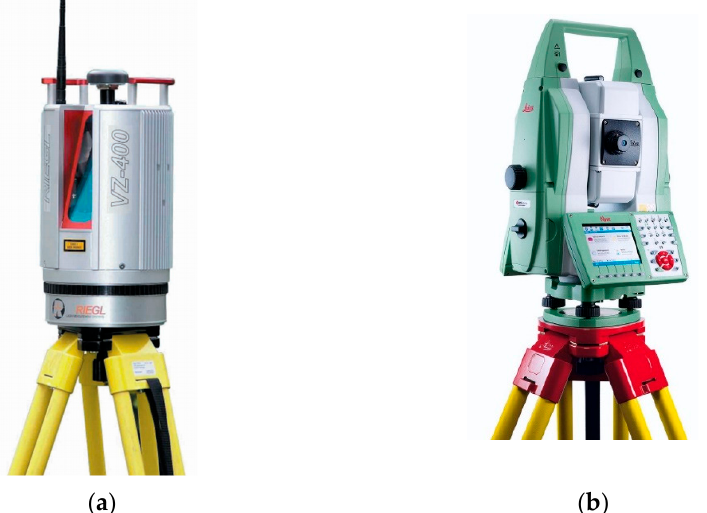
Figure 2. Scanning devices used in the experiments: ( a ) Riegl VZ-400; ( b ) Leica MS50.